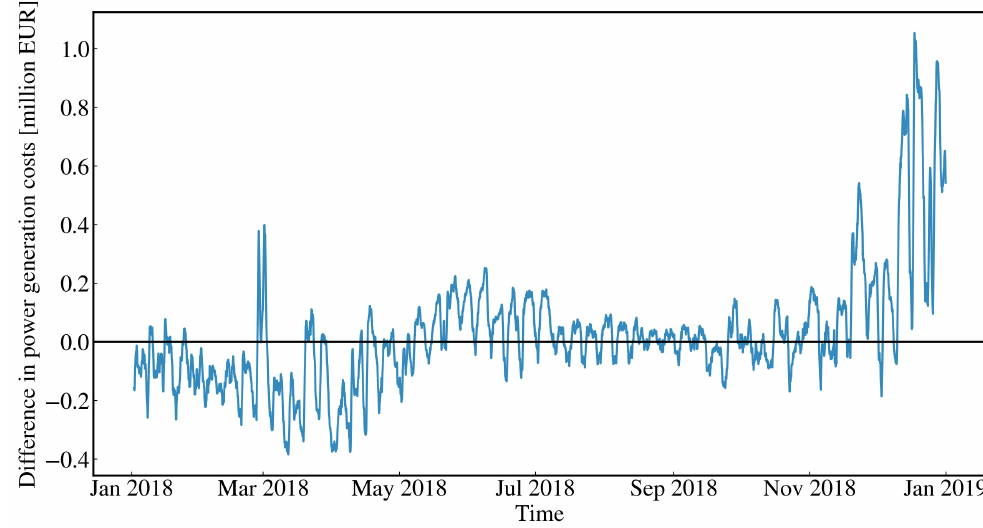
Figure 5. Difference in power generation costs between SOC _ HEUR ( 1000,0 ) and SOC _ HEUR ( 1000,1000 ) . Displayed is the differences in power generation costs in million EUR. Displayed is the daily rolling average of the cost time series.